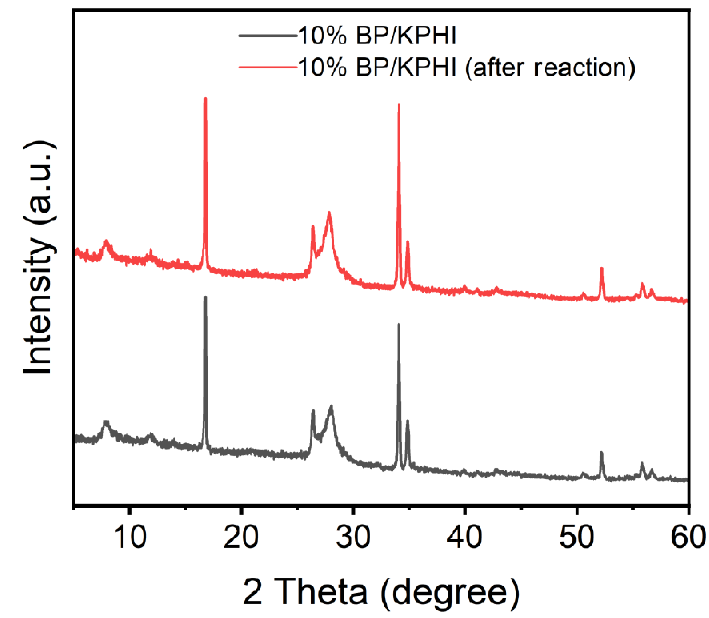
Figure 11. XRD patterns of 10%BP/KPHI and 10%BP/KPHI (after H 2 production reaction).